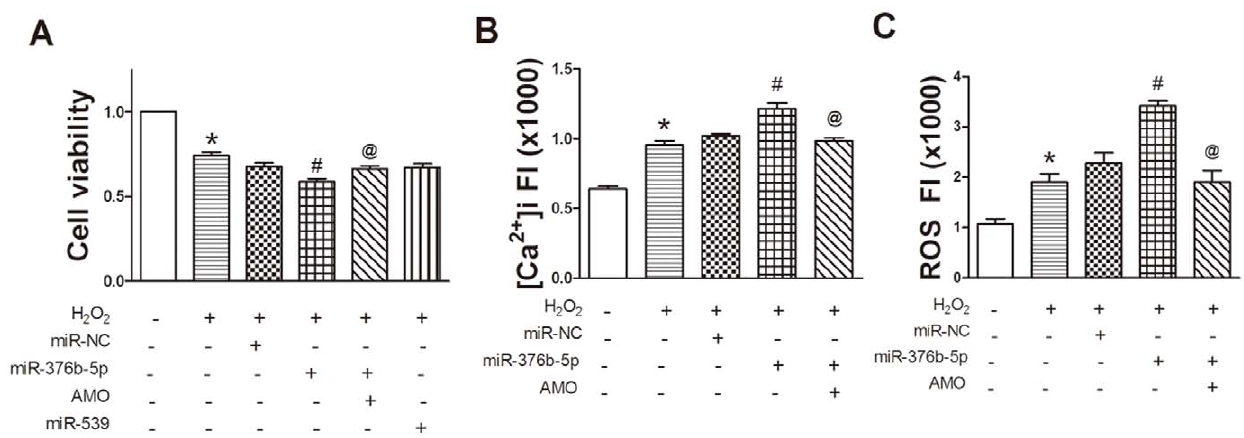
Figure 2. MiR-376b-5p promotes H 2 O 2 -induced H9c2 cells injury. H9c2 cells were pre-treated with H 2 O 2 (50 m M) for 12 h and then transfected with miR-376b-5p negative control (miR-NC), miR-376b-5p, miR-539, and 2 9 -O-methyl-modified antisense oligoribonucleotides of miR- 376b-5p (AMO-376b-5p, miR-376b-5p inhibitor) for 24 h. (A) MTT assay. MiR-376b-5p, not miR-539, reduced cell viability in H 2 O 2 -treated H9c2 cells. n=19 values from 5 independent experiments. (B) Intracellular Ca 2 + concentration ([Ca 2 + ]i) fluorescence intensity. MiR-376b-5p significantly increased [Ca 2 + ]i and this effect was reversed by AMO-376b-5p (AMO). n=29 cells from 5 independent experiments. (C) Reactive oxygen species (ROS) fluorescence intensity. MiR-376b-5p significantly increased relative fluoresence intensity of ROS. n=12 cells from 3 independent experiments. Values were expressed as mean 6 SEM; * P , 0.05 vs. Control, # P , 0.05 vs. H 2 O 2 + miR-NC, @ P , 0.05 vs. H 2 O 2 + miR-376b-5p. FI: fluorescence intensity.